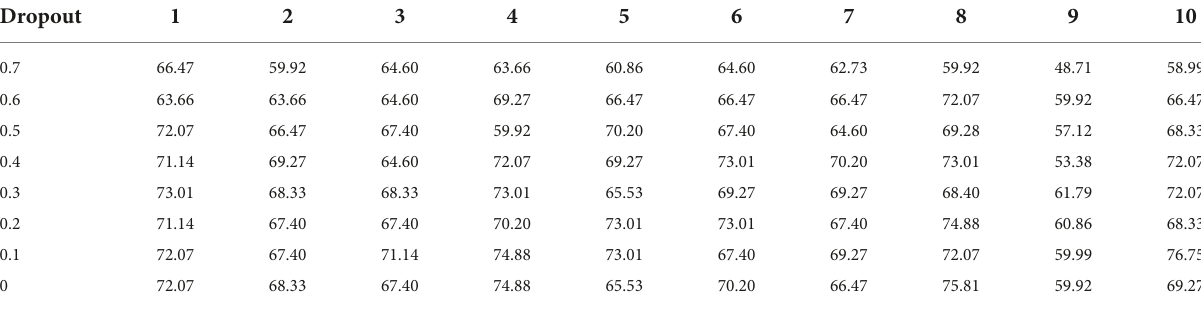
TABLE 2 Performance comparison in ten model cross validation with SA-Bi-LSTM. Dropout